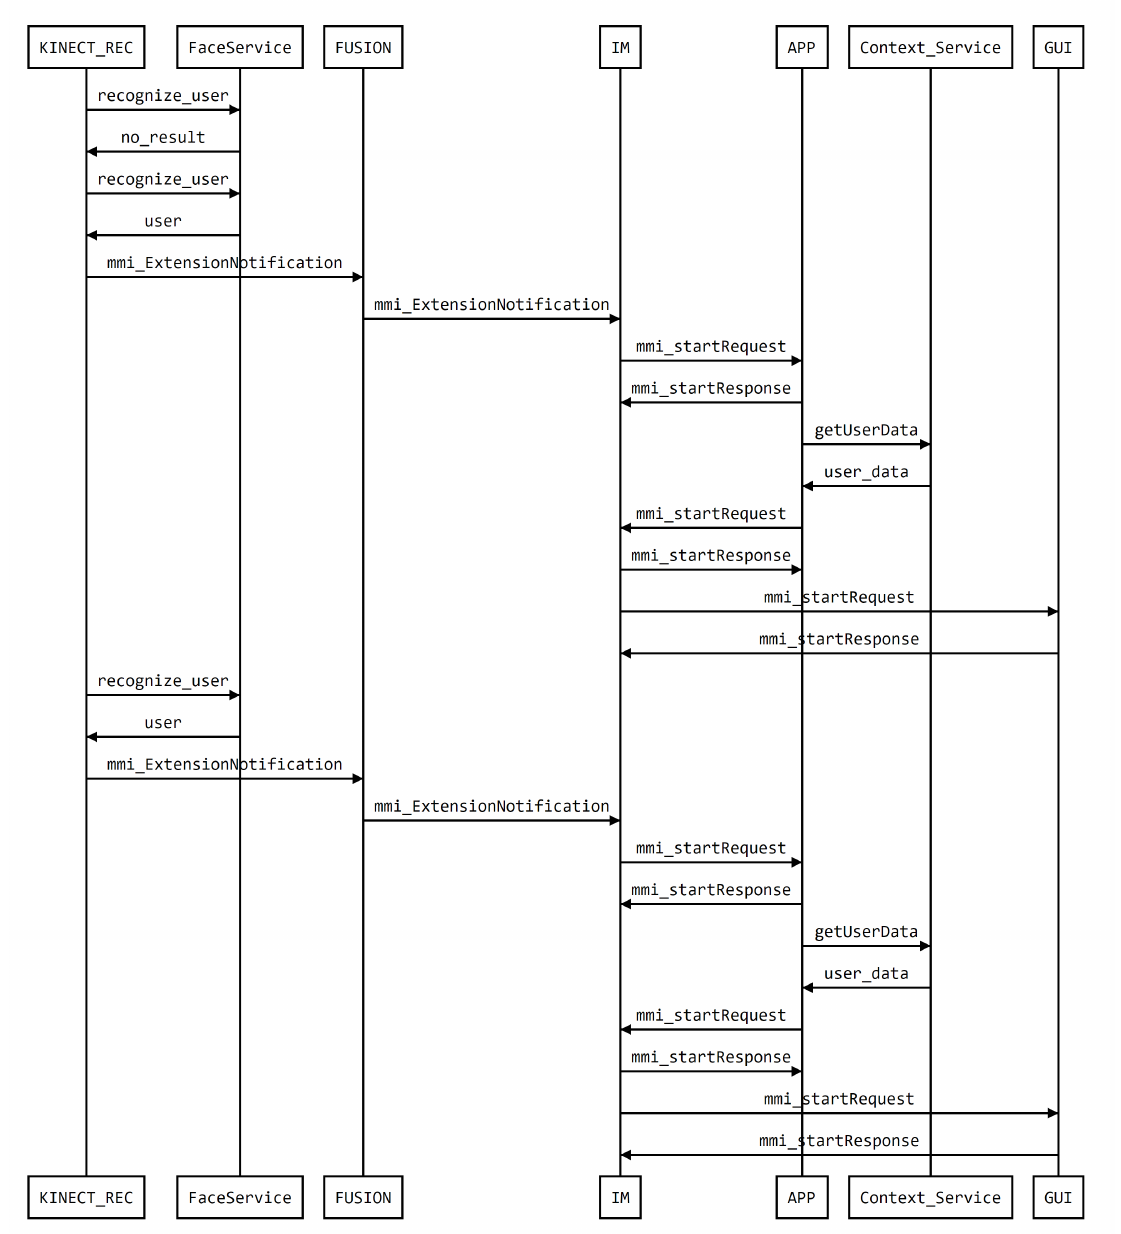
Figure 11. Sequence Diagram of the messages exchanged by the framework in the execution of this